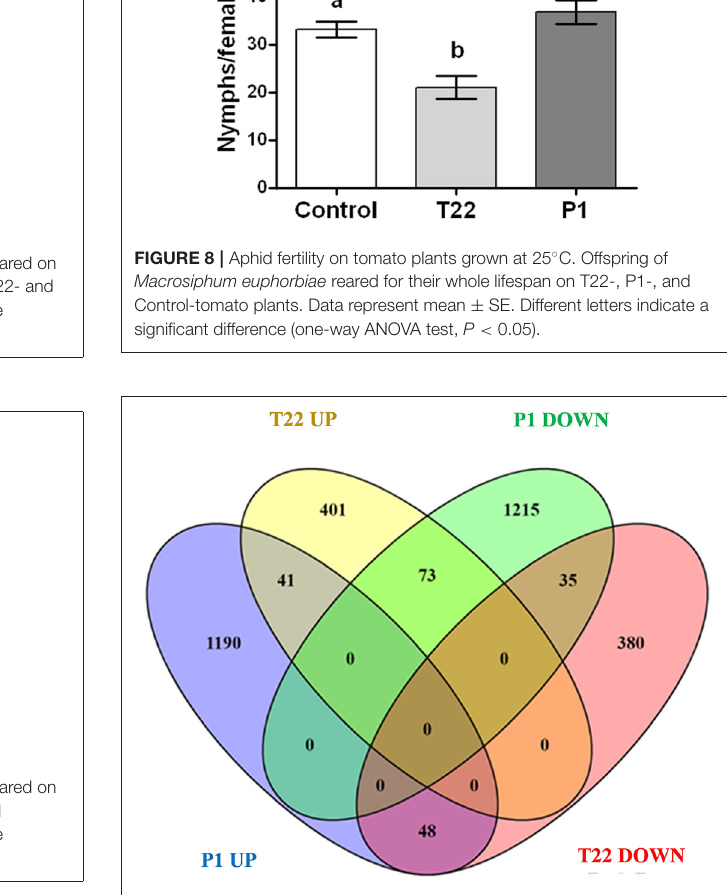
FIGURE 9 | Venn diagram visualization of differentially regulated genes (DEGs) in P1 and T22 treated plants at 20 ◦ C. DEGs of tomato plants inoculated with T. atroviride P1 (P1) and tomato plants inoculated with T. afroharzianum T22 (T22). TABLE 2 | Common DEGs of datasets coding for transcription factors in tomato treated with Trichoderma strains P1 or T22 and grown at 20 ◦ C.